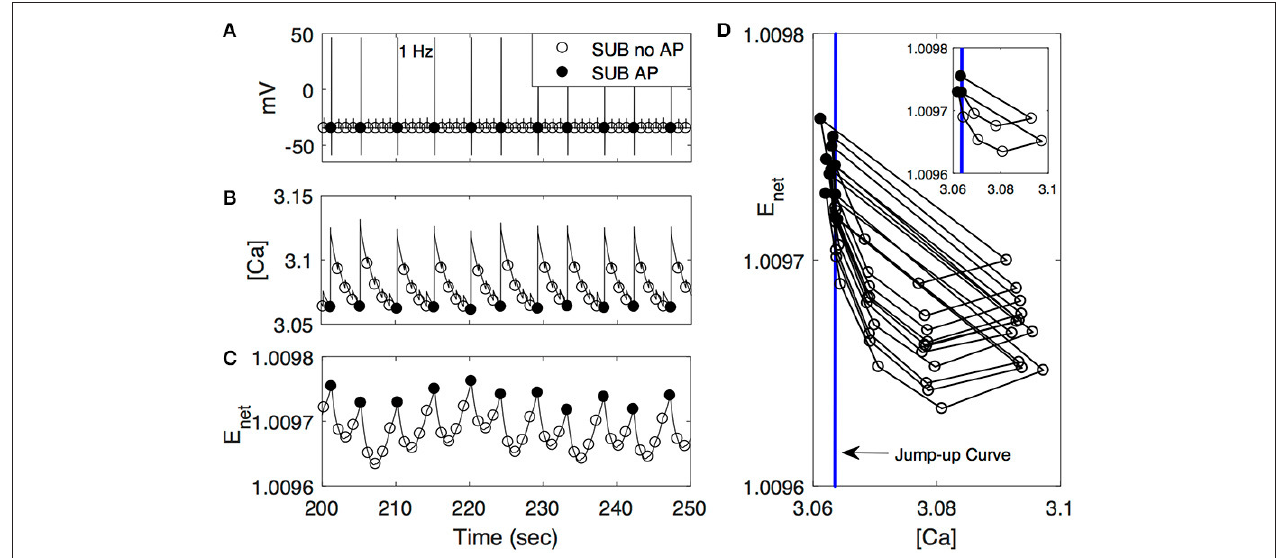
FIGURE 6 | Activity patterns of voltage (A) , [Ca] (B) , and E net (C) in subordinate-like case (SUB) from 200 to 250s at 1Hz. As in Figure 5 , closed circle denotes that the cell fires action potentials (AP) accordingly while open circle denotes no action potential (no AP). (D) ([Ca], E net )-space with the simplified projection of the solution trajectory with the jump-up curve (vertical line). The insert figure plots only the first 10 solution trajectories.